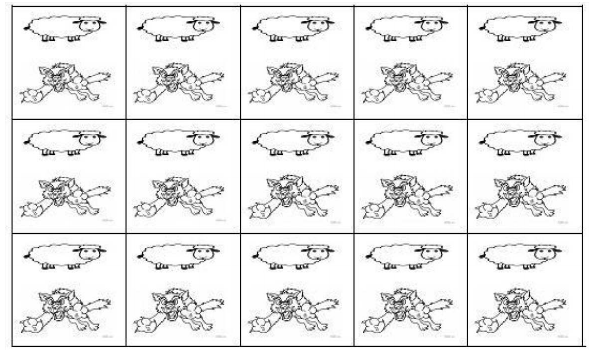
Fig. 5 All patch predators coexist with